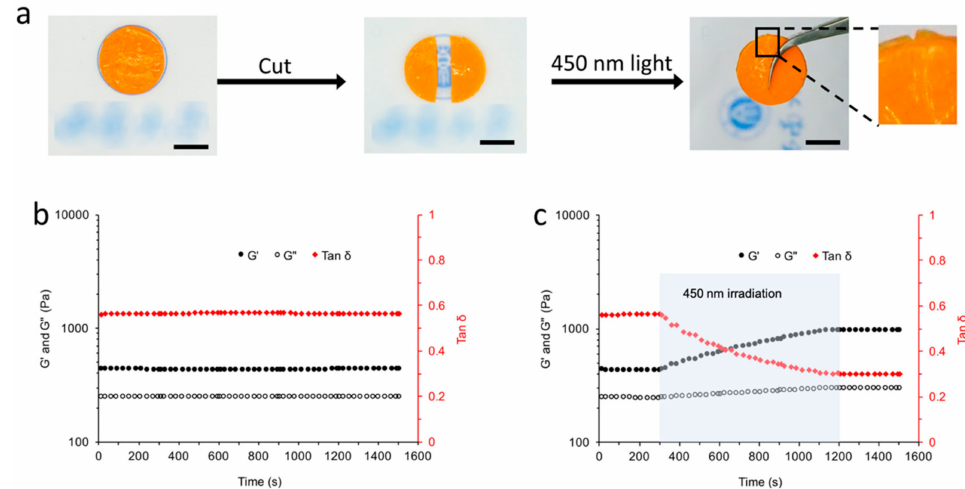
Figure 7. ( a ) The 450 nm light induced gel splicing. In addition, the mechanical properties of the gel stack ( b ) without and ( c ) with 450 nm irradiation.